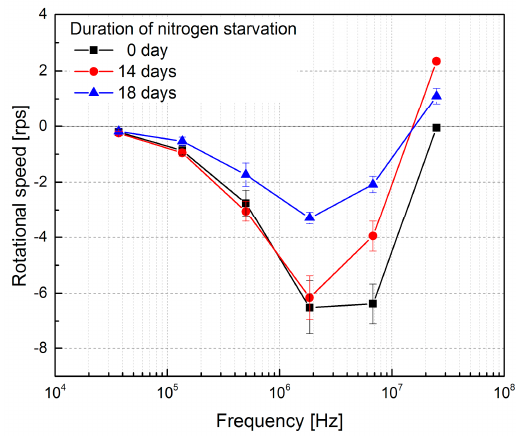
Figure 4. The experimental electrorotation spectra of microalgae cells enduring different periods of nitrogen